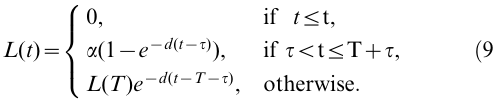
Table S1 Estimates of the parameters after fitting three models to three sets of artificial data. Table S2 Average turnover rates of CD4 + T cells from four healthy humans as estimated by fitting experimental data. Table S3 Average turnover rates of CD8 + T cells from four healthy humans as estimated by fitting experimental data. Text S1 Derivation of the model with continuous kinetic